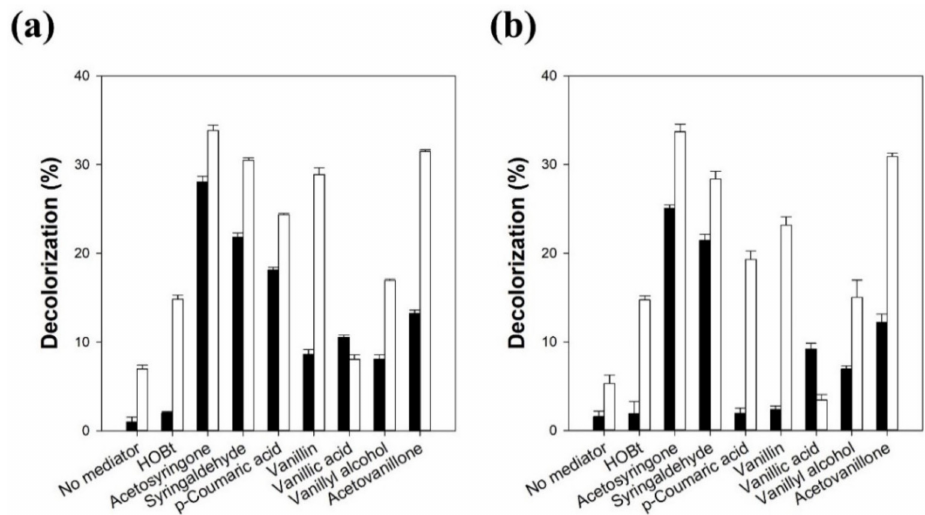
Figure 1. The effect of mediators on the melanin decolorization by LMS using laccase from T. versicolor ( a ) and M. thermophila ( b ). Black and white bars represent 5 h and 24 h reactions, respectively. Reaction conditions: 50 µ g/mL melanin, 0.1 mM mediator, and 0.1 M citric acid phosphate buffer (pH 5.5) at 25 ◦